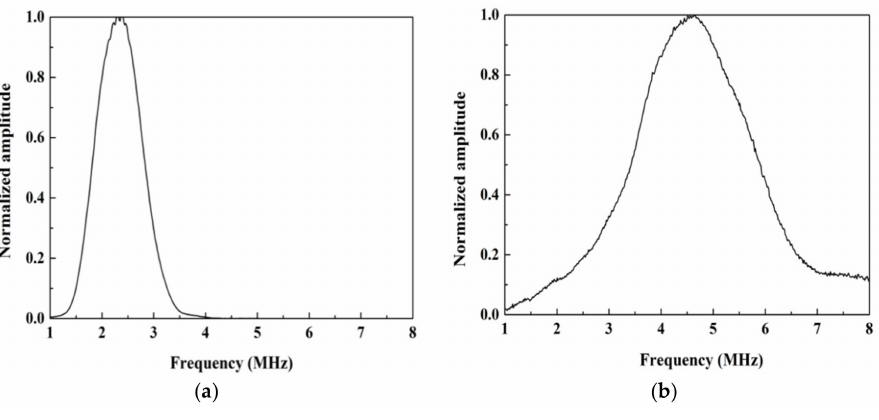
Figure 1. Frequency response range of the ( a ) excitation and ( b ) receiving transducers. Nonlinear Lamb waves are excited and received in the CFRP laminates through two longitudinal ultrasonic transducers mounted on Plexiglas wedges at an angle of 45 ◦ . The optimal distance between the Plexiglas wedges is 60 mm. Mount 7501 high-vacuum silicone grease is applied as the coupling agent, and the excitation and receiving transducers are positioned along the same straight line. A special fixture is employed to ensure full coupling between the sensors and samples during detection under constant pressure.